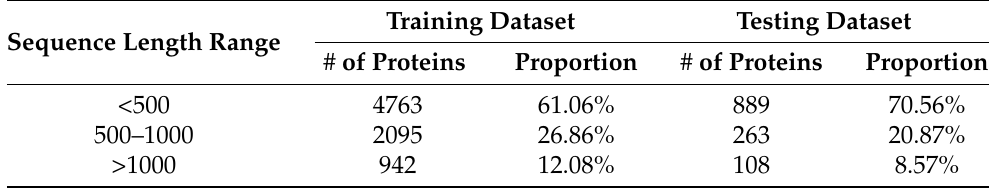
Table 1. The ratio of protein sequence length distribution of the training and testing